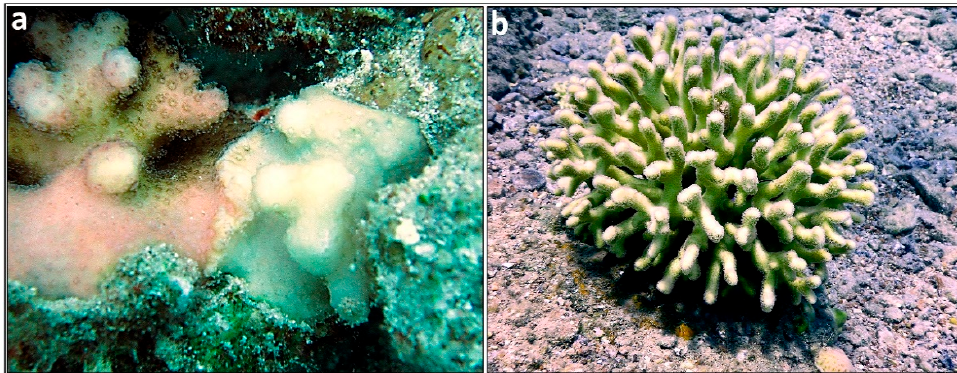
Figure 1. ( a ) The allogeneic encounter of two juvenile colonies of S. pistillata . These two individu- als did not fuse, and they stay in constant conflict interactions [39]. ( b ) An adult colony of S. pistil- lata in Eilat’s shallow reef. Both photos were taken in the northern Gulf of Eilat using a Canon G7